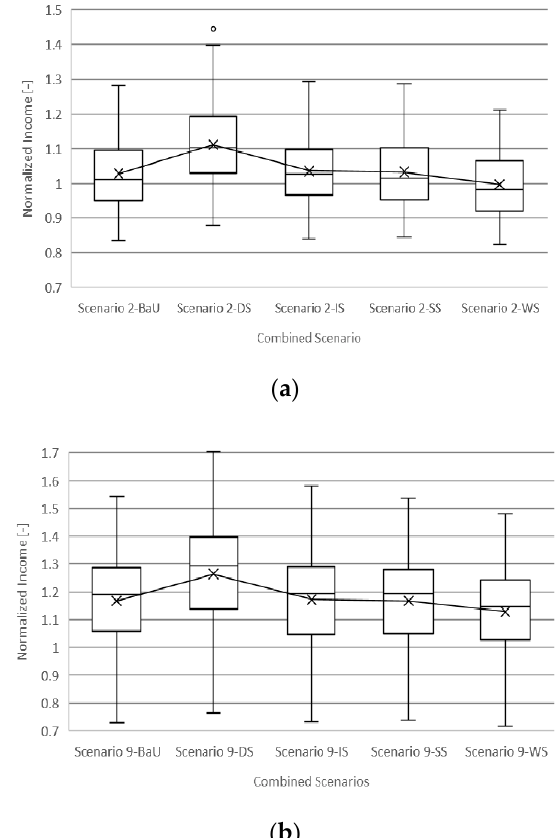
Figure 10. Boxplots of the normalized incomes according to 2015 for the mixed scenarios at 2030 scenarios. ( a ) Climate scenario 2 with all price scenarios and ( b ) climate scenario 9 with all price